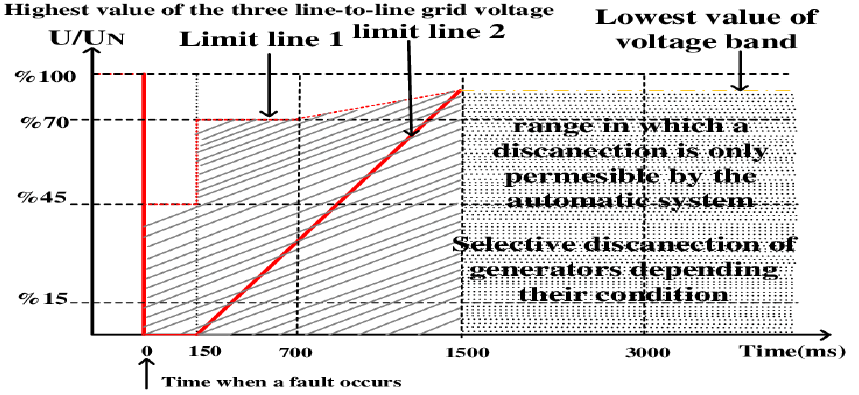
Figure 10. LVRT standard set.